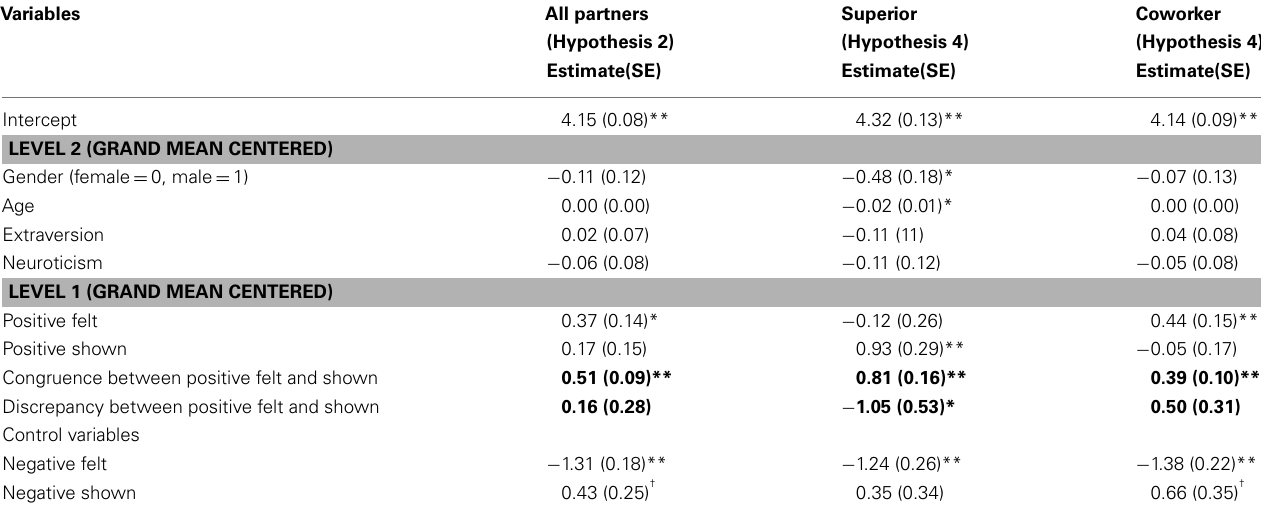
Table 4 | Predicting goal attainment in workplace interactions from positive felt and shown (Hypothesis 2 and Hypothesis 4).